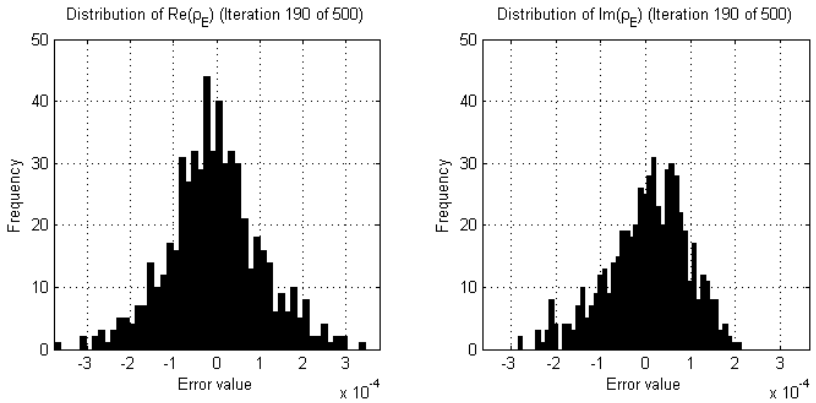
Figure 2. Examples of histograms demonstrating estimates of the probability distribution of the real and imaginary parts of the data error ( ρ E ) during a DGM-CSI inversion of an arbitrary 2D synthetic breast model early in the reconstruction process (iteration 20).